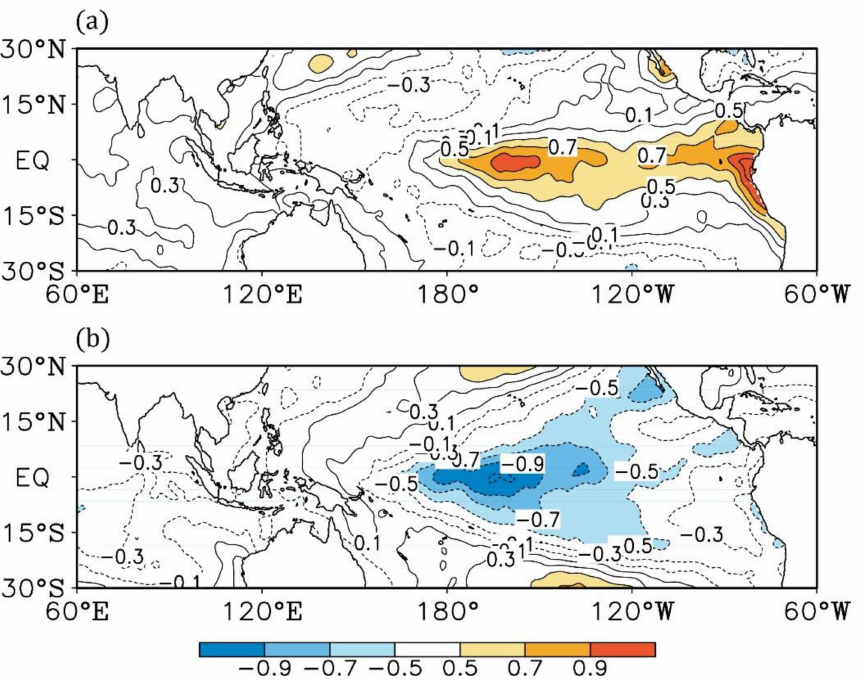
Figure 3. Composite anomalies of the decaying spring sea surface temperature (SST) (contours and colors; units: ◦ C) for the ( a ) El Niño cases and ( b ) La Niña cases. All data are linearly